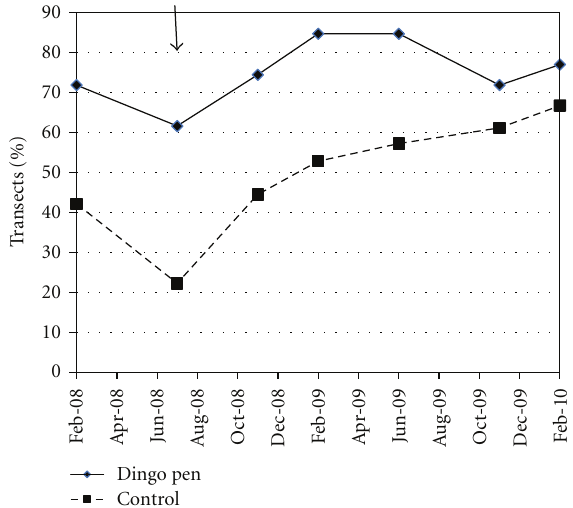
Figure 5: The percentage of transects (Dingo Pen n = 39, control n = 38) with rabbit tracks recorded within the Dingo Pen and control area. The arrow indicates when dingoes were released into the pen in December